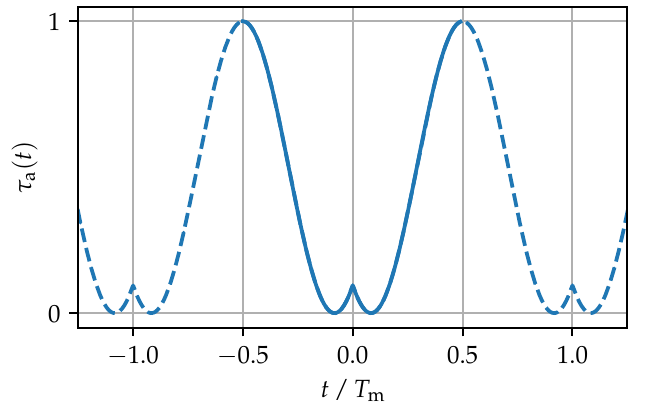
Figure 3. Transmission τ a of the MZM with φ 0 = 0.8 π and φ m = 1.2 π . Solid line: within one period T m , dashed line: outside the